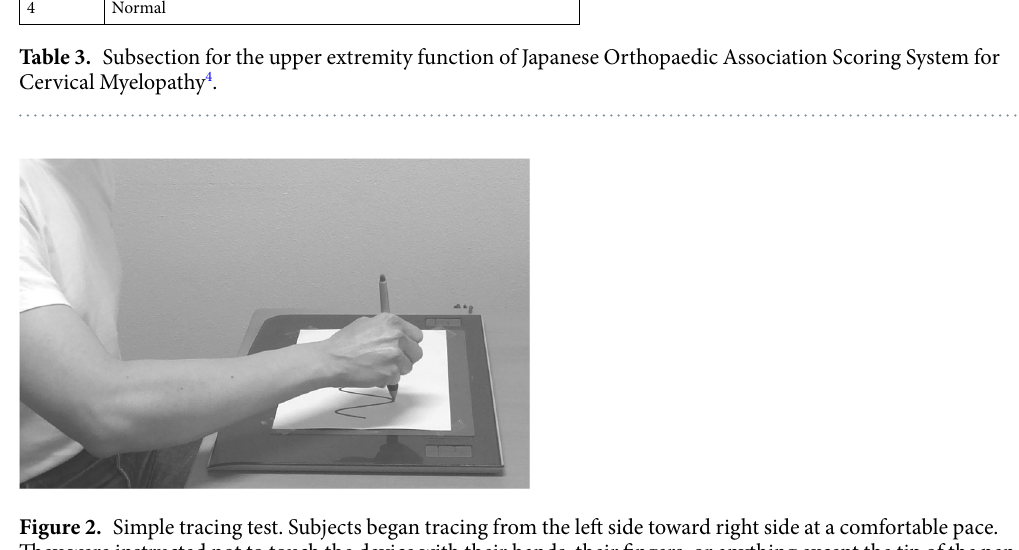
Figure 2. Simple tracing test. Subjects began tracing from the left side toward right side at a comfortable pace. They were instructed not to touch the device with their hands, their fingers, or anything except the tip of the pen while performing the tracing